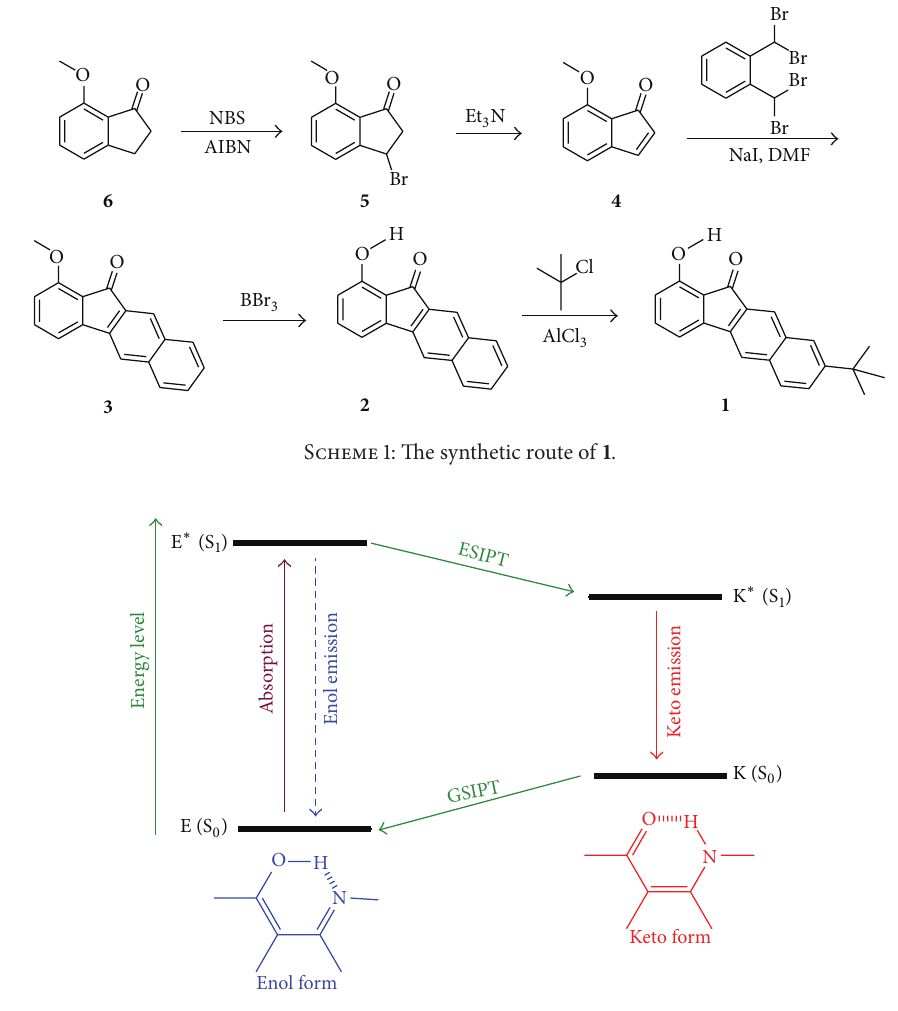
Figure 1: Characteristic four-level photocycle scheme of the ESIPT